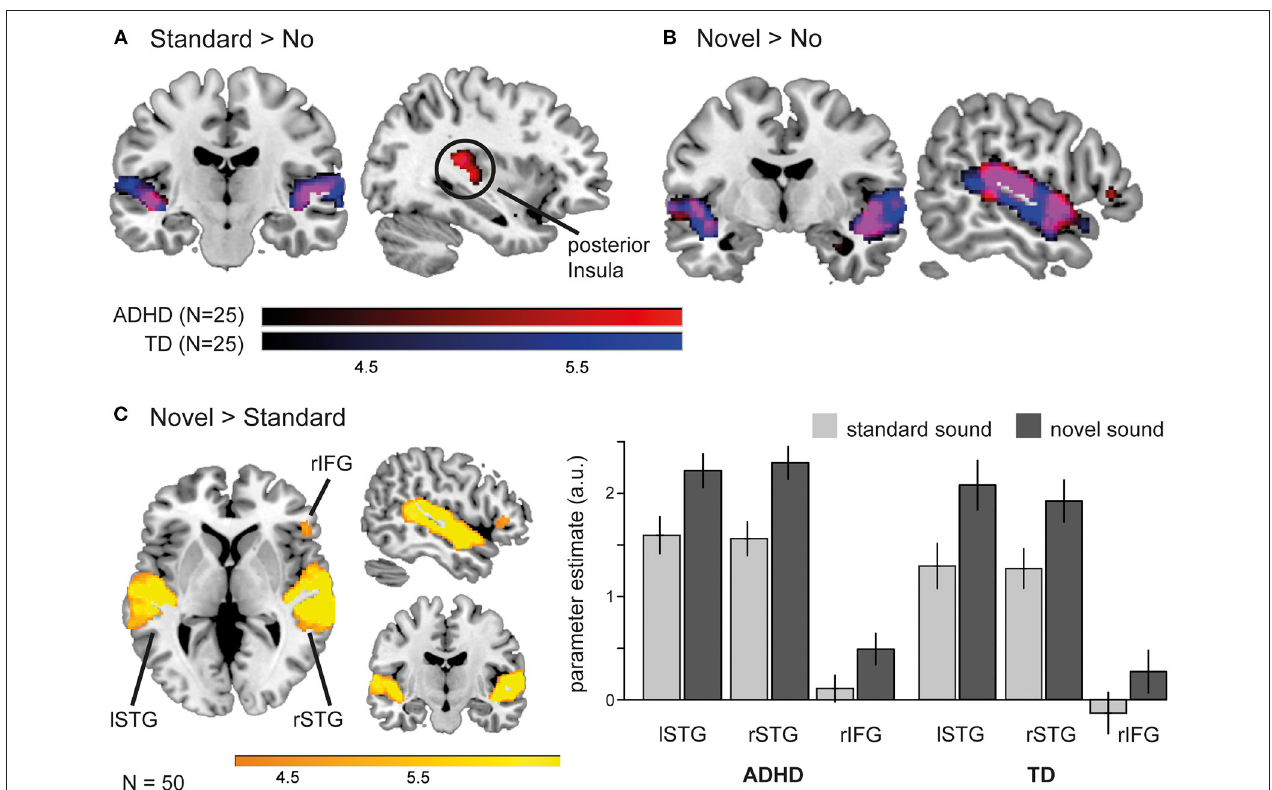
FIGURE 3 | The influence of task preceding sounds on neural activation pattern during task execution. (A) Standard sounds modulated brain activity in ADHD patients (red) and TD peers (blue) in the bilateral superior temporal gyri (STG), but involved the posterior insula only in the patient group. (B) Novel sounds activated an overlapping (purple) network in children with (red) and without (blue) ADHD when compared to a baseline without sound ( p < 0.001). (C) Direct comparison between novel and standard sounds revealed that novelty causes a significant increase in neural activity in the bilateral STG and right inferior frontal gyrus (rIFG) in all